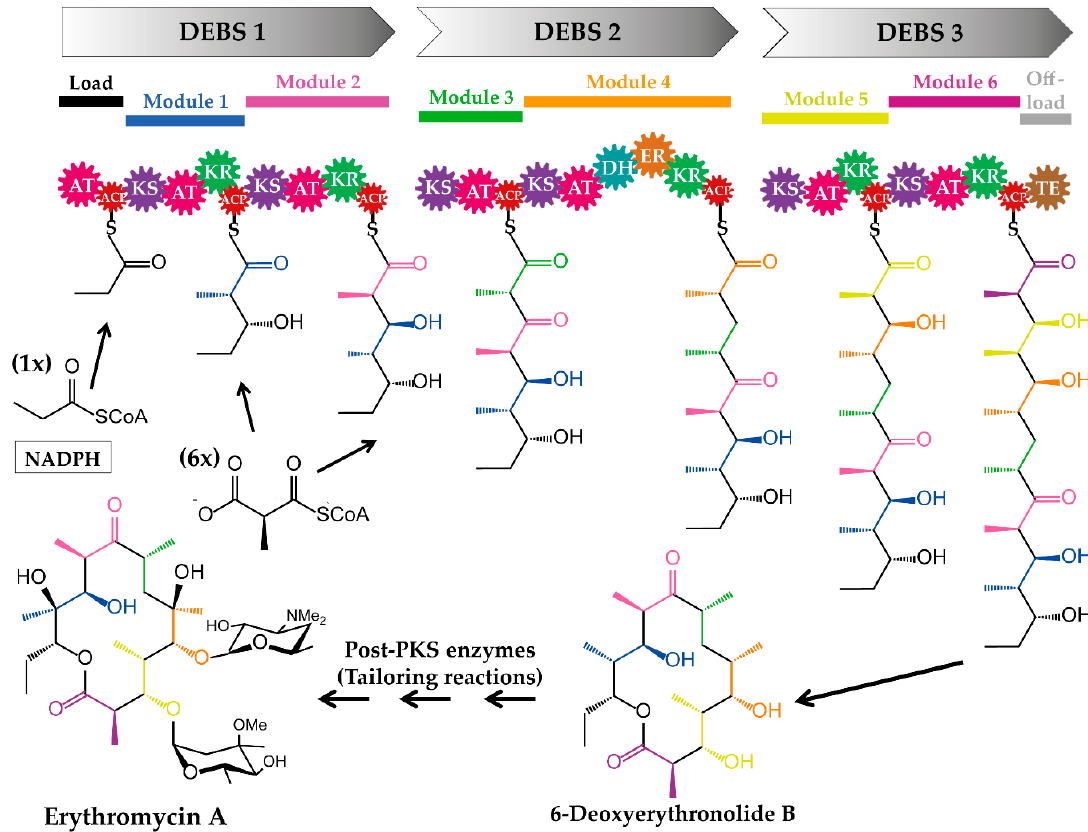
Figure 2. The erythromycin assembly line (DEBS) [20,21]. The prototypical type I modular PKS machinery is composed of three subunits DEBS 1, DEBS 2 and DEBS 3, which are organized into modules. Each module contains a set of domains catalysing one elongation step. The biosynthesis of the chain begins with the loading of the starter unit (derived from propionyl-coenzyme A(-CoA)) onto the loading module (load). Subsequently, the polyketide chain is extended by one extender unit (derived from methylmalonyl-CoA) on each of the “downstream” extension modules. In modules which possess reductive domains (optional), the polyketide intermediate is modified. The synthesized chain is released from the last module (off-load) by the thioesterase domain. Finally, the generated erythromycin intermediate (6-deoxyerythronolide B) is further processed in the post-PKS steps (tailoring). PKS domains: AT, acyltransferase; ACP, acyl carrier protein; KS, ketosynthase; DH, dehydrogenase; KR, ketoreductase; ER, enoylreductase; TE, thioesterase.